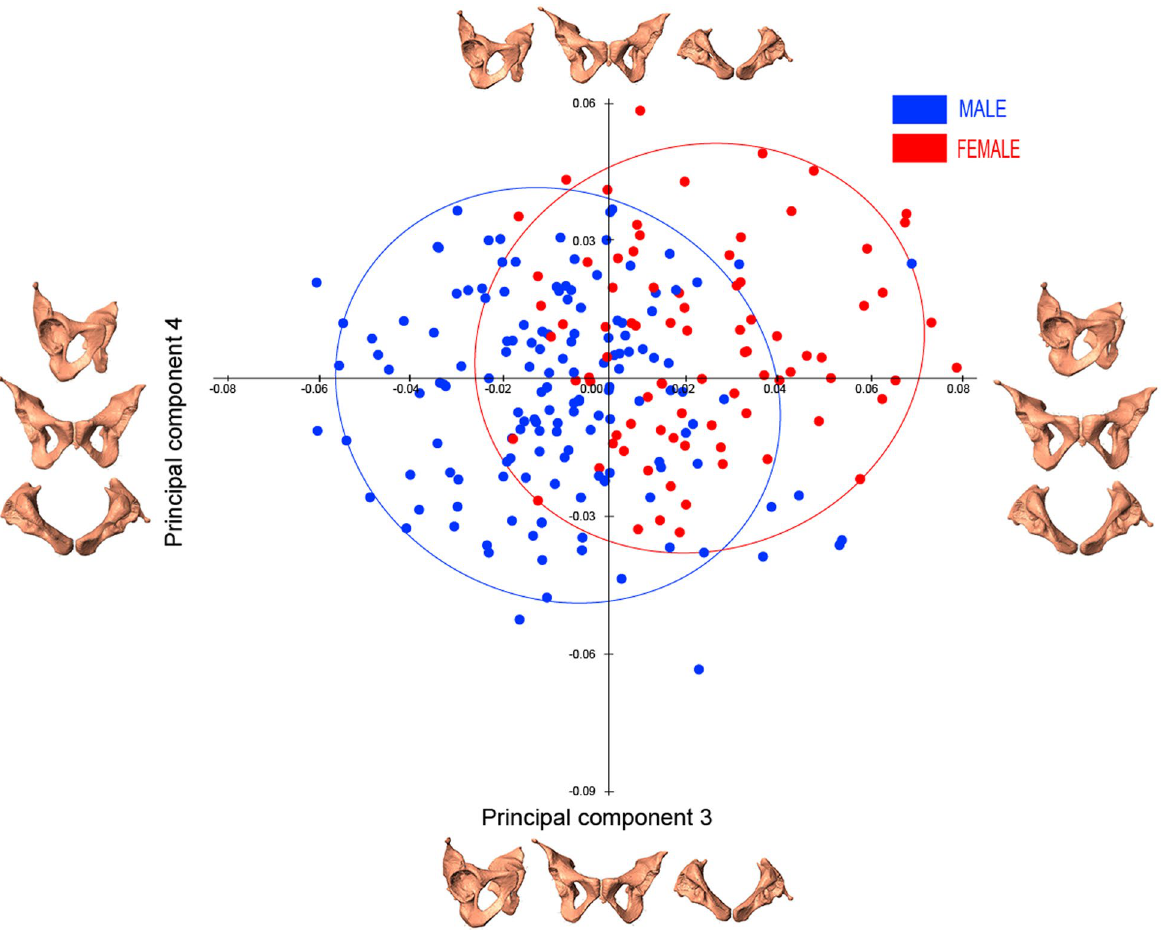
Fig. 4 The principal component plots for PC3 and PC4 with the 90% confidence ellipses for sex classification